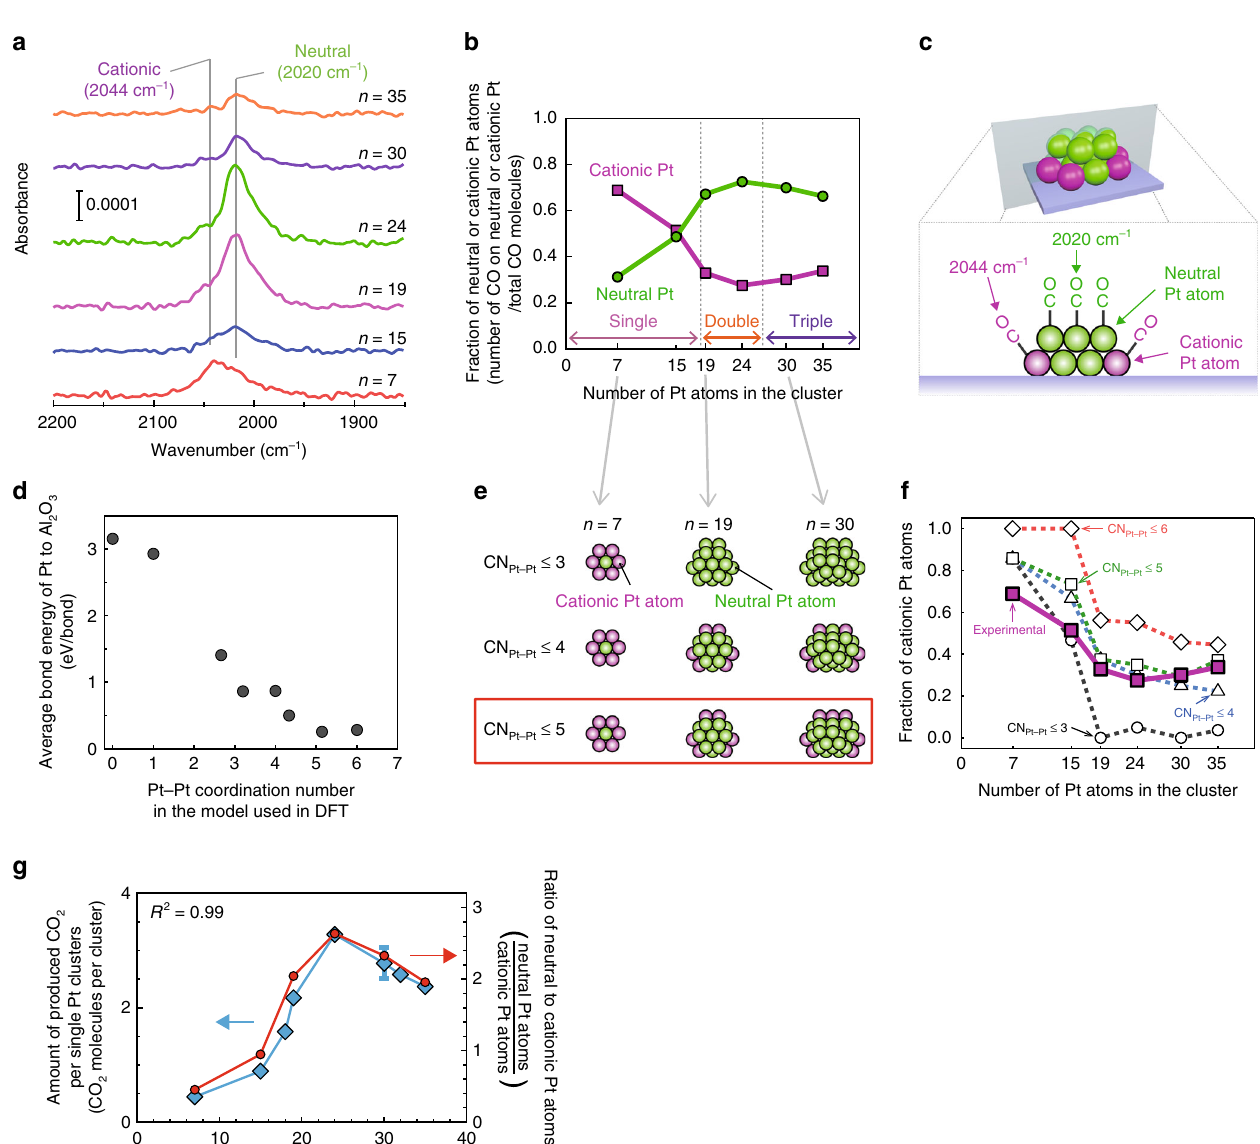
Fig. 3 Chemical states of Pt and their effect on CO oxidation activity. a Infrared re fl ection absorption spectroscopy (IRAS) spectra of 13 CO adsorbed on Pt n /Al 2 O 3 . b Fraction of neutral and cationic Pt atoms estimated from IRAS spectra. Circles and squares represent fraction of neutral and cationic atoms, respectively. c Schematic diagram illustrating the adsorption of CO on a Pt cluster. d Average bond energy of Pt – Al 2 O 3 determined using density functional theory (DFT) calculations. A linear increase in the bond energy between Pt and Al 2 O 3 is observed as CN Pt – Pt is decreased from 5 to 0. The structural models used for these calculations are shown in Supplementary Fig. 12a. e Schematic diagram of clusters showing the location of cationic Pt atoms for different Pt coordination numbers. f Fraction of cationic Pt atoms in the cluster. Good agreement with the experimental data (purple squares) is observed for X = 5 (open squares). X = 3, 4, and 6 are represented as open circles, open triangles, and open diamonds, respectively. g Relationship between the amount of produced CO 2 per Pt single clusters (circles) and the ratio of neutral to cationic Pt atoms (diamonds). The coef fi cient of determination ( R 2 ) between these parameters was calculated to be 0.99 using the least mean square method. The error bar in g is standard deviation. Source data are provided as a Source Data fi